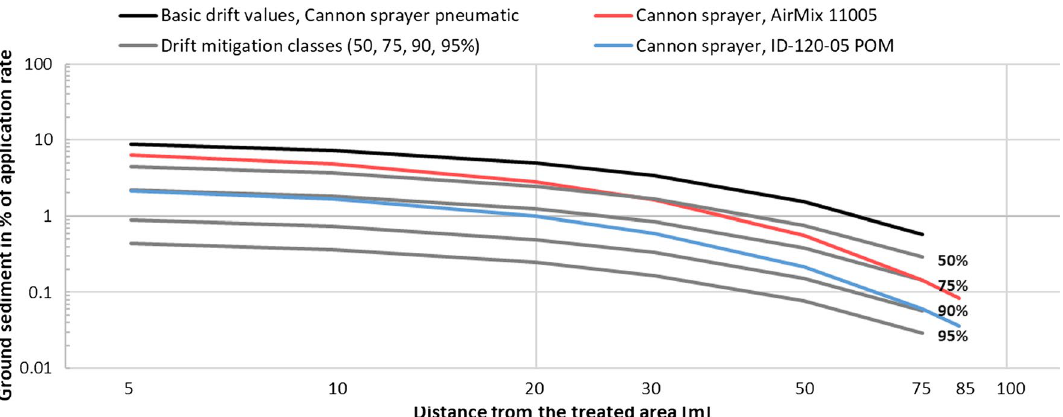
Fig. 5 Spray drift reduction classes (50%, 75%, 90% and 95%) of the pneumatic cannon sprayer and adjusted medians of the cannon sprayer AirMix 110‑05 and ID‑120‑05 POM for classification of spray drift